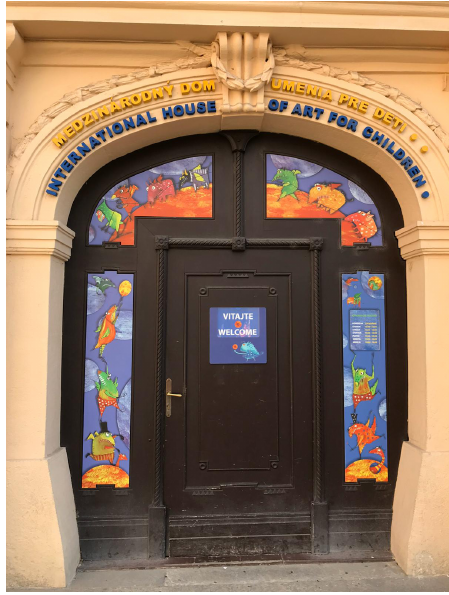
Figure 15. An example using the frame within a frame composition rule.